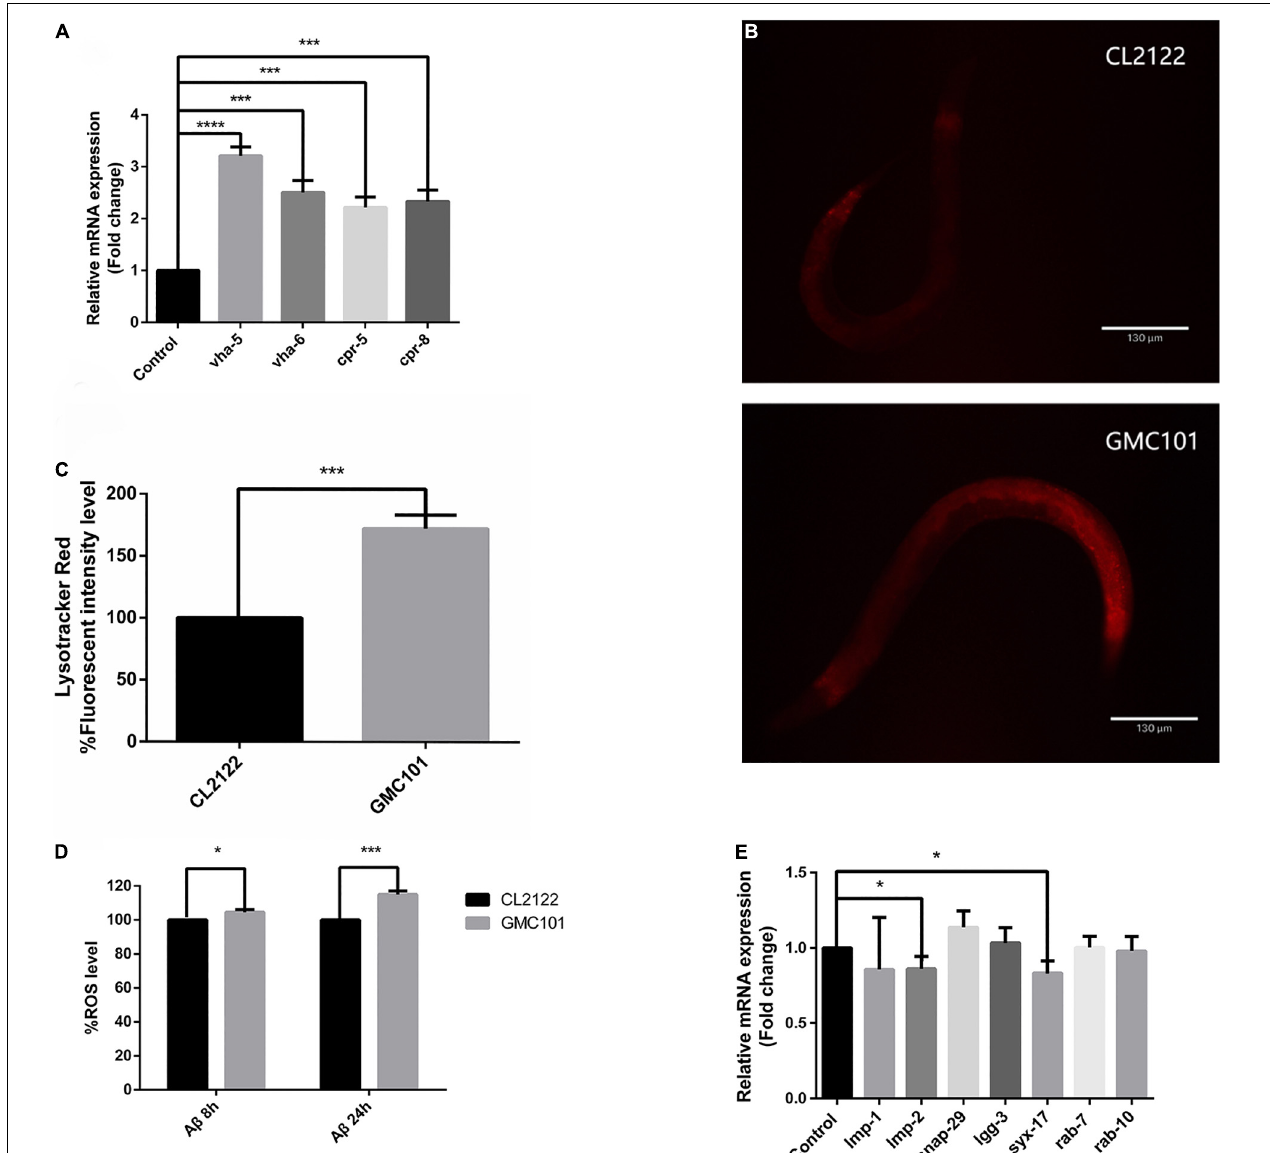
FIGURE 2 | A β enhanced lysosomal acidity in GMC101 compared with CL2122 strains. (A) V-ATPase and cathepsin mRNA expression. (B) Representative fluorescence images of CL2122 and GMC101 strains stained with LysoTracker Red after A β induction for 24 h. (C) Quantified CL2122 and GMC101 fluorescence intensities ( n = 10 for CL2122 and n = 11 for GMC101, repeated three times. *** p < 0.001 by the Student’s t -test). (D) Levels of ROS in transgenic C. elegans . (E) Autophagosome and lysosome fusion gene mRNA expression following A β induction for 24 h. Each group contained about 60 worms ( n = 3, * p < 0.05; *** p < 0.001 by the Student’s t -test; **** p <